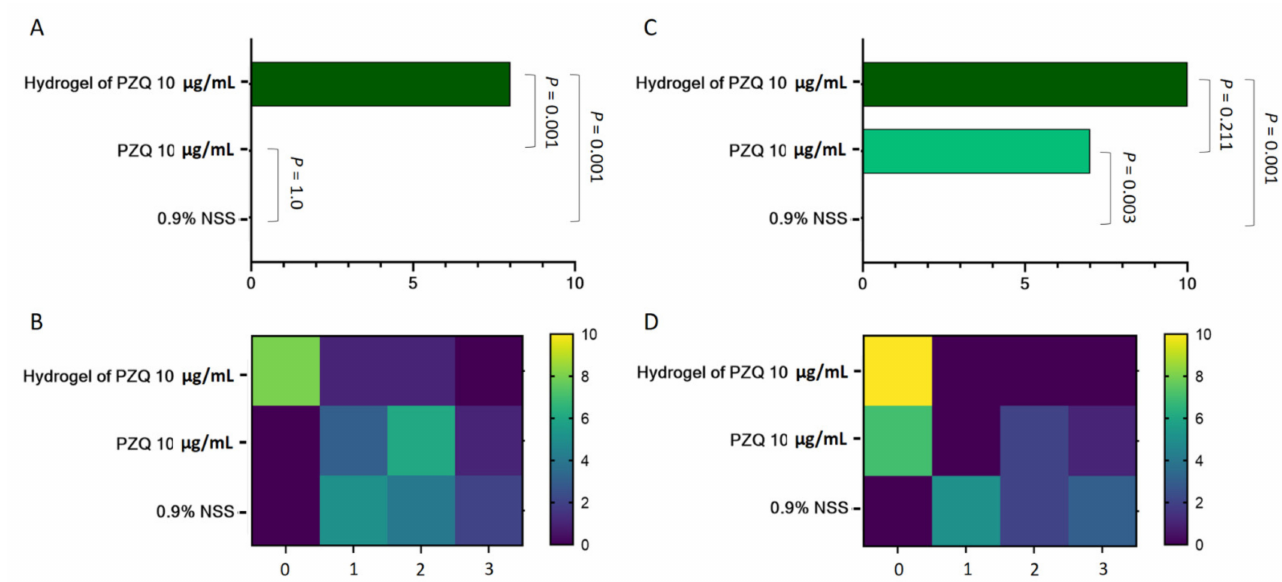
Figure 3. The anthelminthic efficacy of hydrogel of PZQ 10 µ g/mL against P. Gralli . The parasites were treated with the formulation for 12 (panels on the left-hand side) and 24 h (panels on the right-hand side). The untreated and the drug control groups were exposed to the 0.9% normal saline and PZQ 10 µ g/mL, respectively ( n = 10 per group). Data represent the mortality rate of the parasites ( A , C ) and motility score ( B , D ). Experimental data were analyzed using the chi squared test. Significant p -values were highlighted onto the comparable